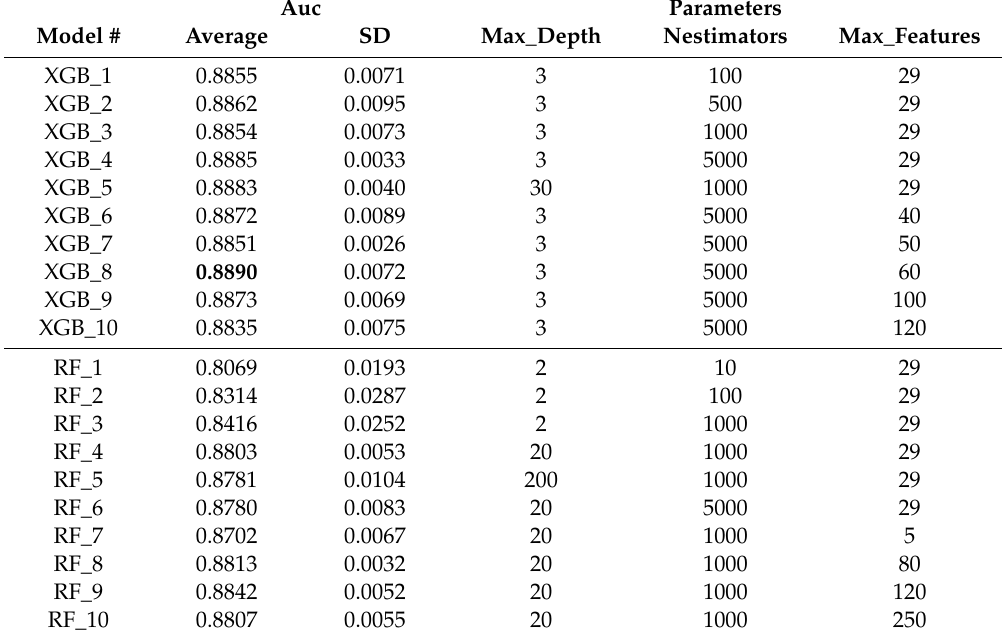
Table 4. Prediction performances in extreme gradient boosting (XGB) and random forest